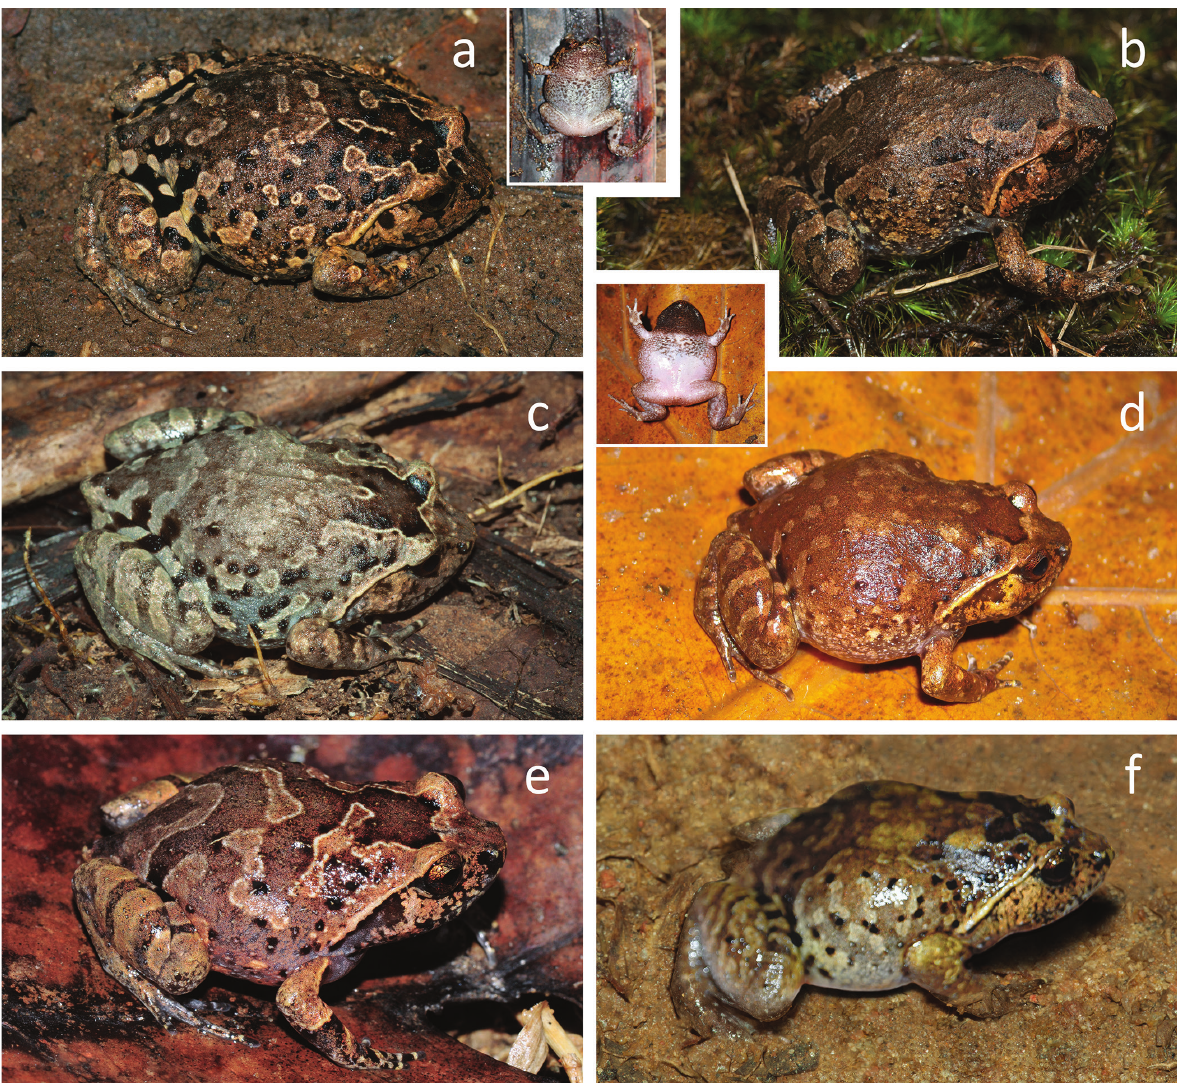
Figure 3. Individuals of Plethodontohyla laevis in life, illustrating the diversity of colour patterns from different sites of the species known distribution range: ( a ) MRSN A6188 from Betampona in dorsolateral and (inset) ventral view; ( b ) MRSN A6181 from Betampona in dorsolateral view; ( c ) FAZC 13898 from Betampona in dorsolateral view (Photos by Gonçalo M. Rosa); ( d ) MRSN A6787 from Aniv- orano Est in dorsolateral and (inset) ventral view (Photo by Jasmin E. Randrianirina); ( e ) ZSM 189/2016 from Analalava-Foulpointe in dorsolateral view (Photo by Frank Glaw); ( f ) individual (not collected) from Ambodiriana in dorsolateral view (Photo by Lauric